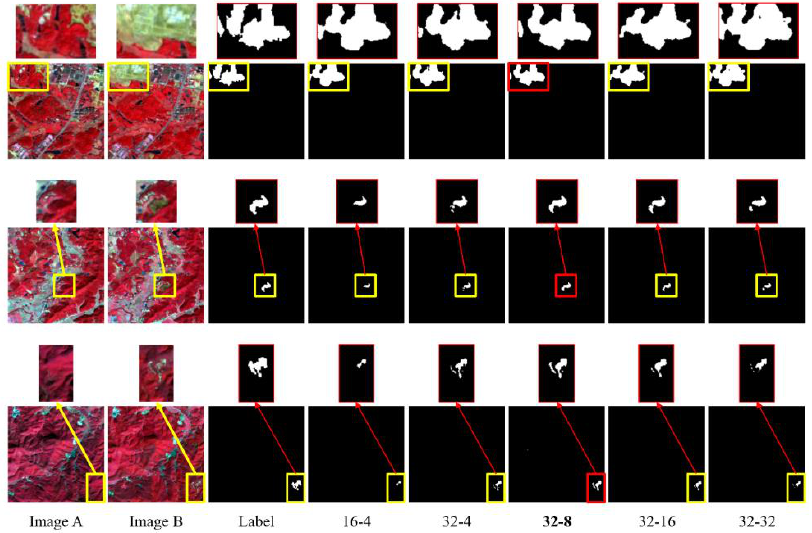
Figure 9. Relationship between the number of initial channels and model performance.